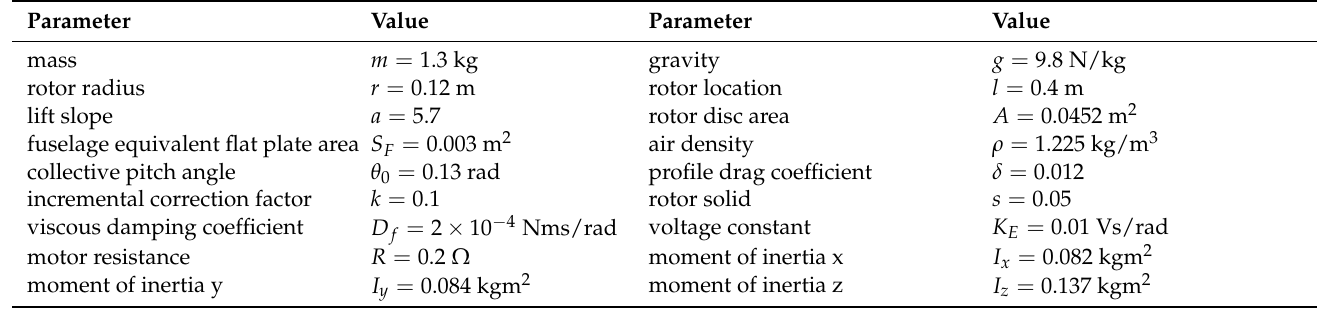
Table 1. Model parameters of a quadrotor UAV